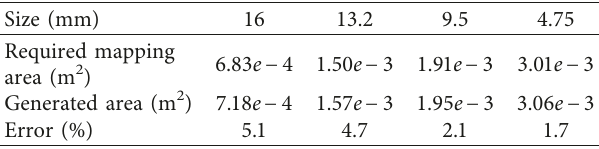
Table 4: Summaries of the coarse aggregates. Size (mm)